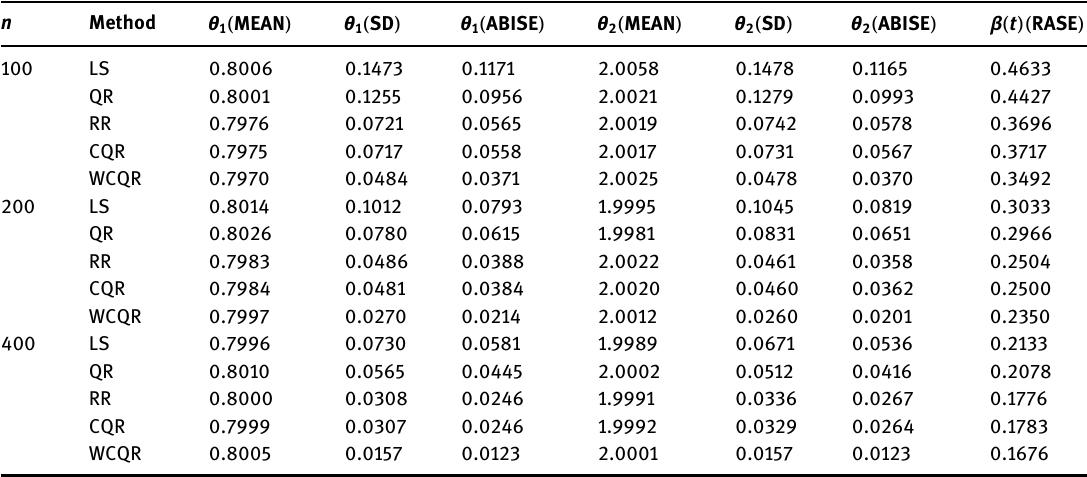
Table 4: Simulation results for θ with Exp ( 1 ) random error